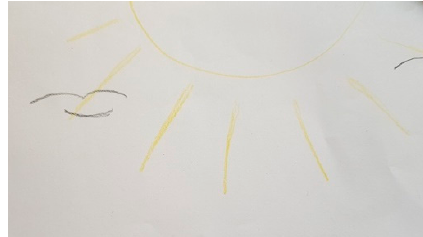
Figure 11. P40’s perception of DBS’s effect.